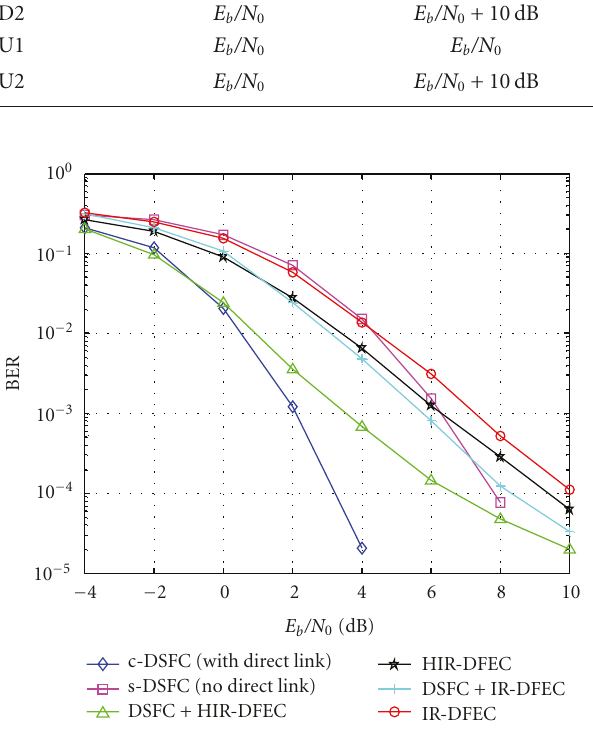
Figure 5: BER versus E b /N 0-directlink ; DSFC, DFEC, and DSFC+DFEC algorithms—scenario D1.